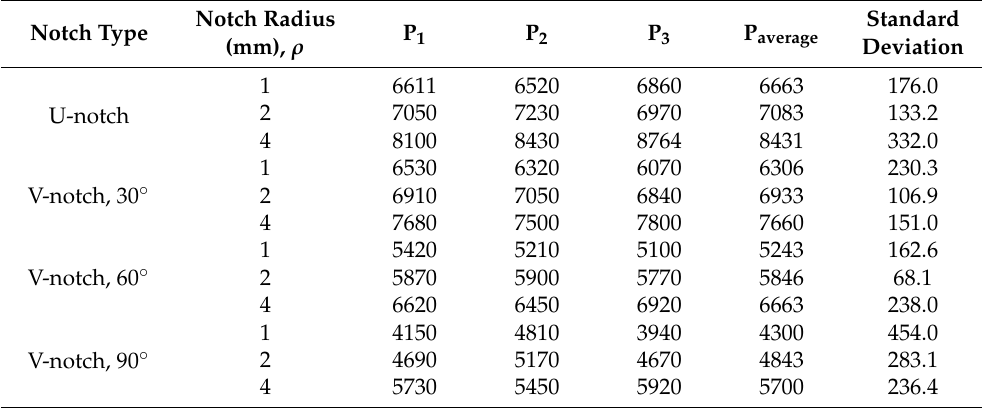
Table 2. Experimental fracture loads (N) of unidirectional composite Brazilian